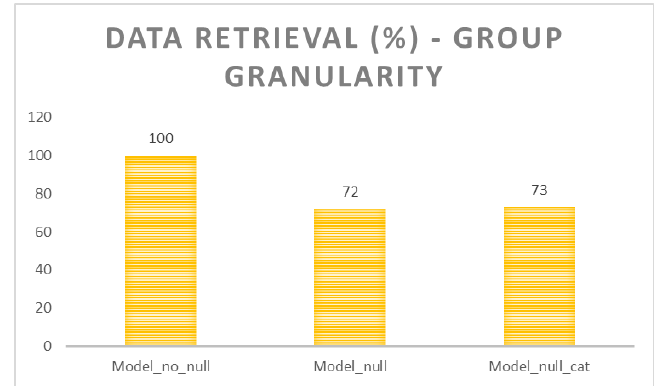
Figure 23. Data retrieval—NULL management layer.